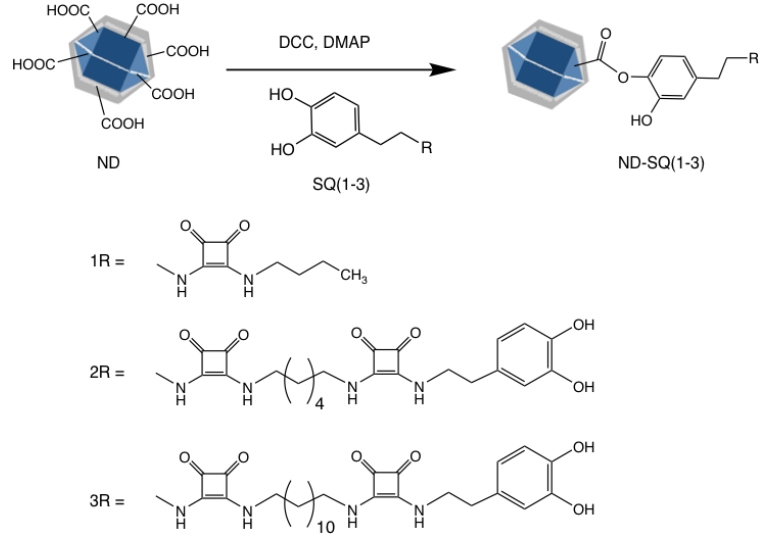
Figure 1. Scheme of the preparation of hybrid nanodiamond squaramide derivatives used in this study (ND-SQ(1 − 3)).